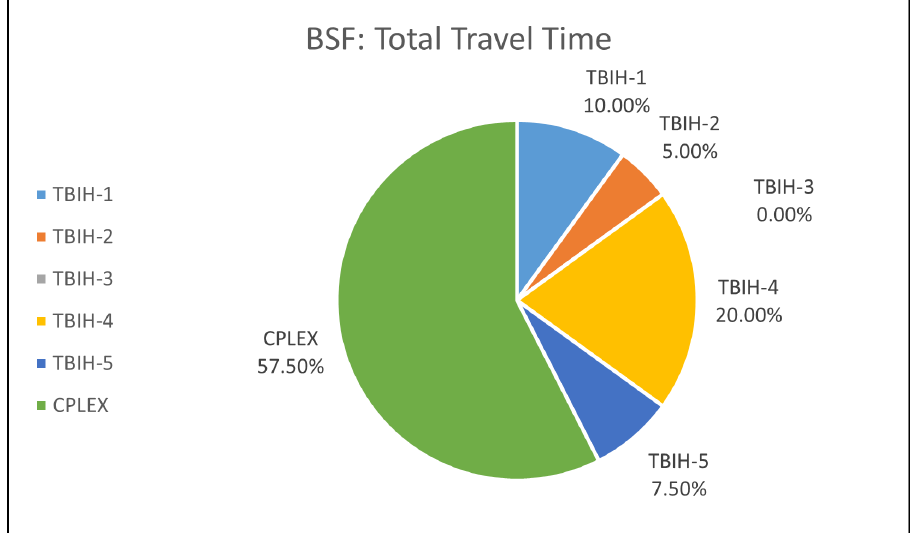
Figure A21. Algorithms performance compared to matheuristic rollout applied in PDS-RA: total BSF measured for total travel time over all test instances applied (omitting 10 non-benchmarked